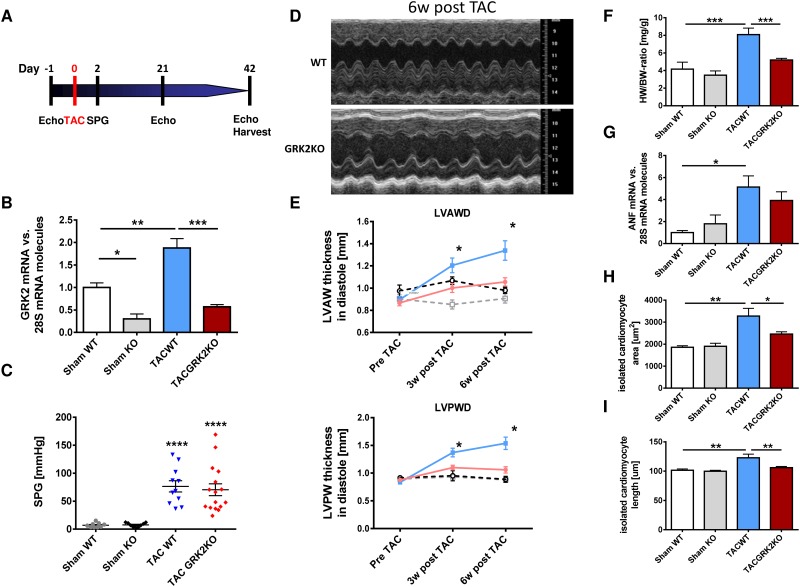
G-protein coupled receptor kinase 2 knockout (GRK2KO) attenuates cardiac hypertrophy in vivo.(A) Study design and in vivo model of pressure overload hypertrophy. Experimental protocol, echocardiography (Echo), transverse aortic constriction (TAC), Doppler measurement of systolic pressure gradient (SPG), organ harvest at study end (Harvest). (B) GRK2 mRNA expression normalized to 28s RNA 6 weeks after TAC operation, n = 3 for KO, n = 4–5 for WT groups, * P < 0.05, ** P < 0.01, *** P < 0.001. (C) Doppler measurement of aortic systolic pressure gradient (SPG) after TAC, n = 9 for sham, n = 11 for TAC WT and n = 16 for TAC GRK2 group. *** P < 0.0001 for TAC vs. Sham groups. (D) Representative M-Mode echocardiography recordings at study end, 6 weeks post TAC. (E) Echocardiographic assessment of ventricular remodeling. Left ventricular anterior/posterior wall thickness/diameter (LVAWD and LVPWD) determined before, 3 weeks and 6 weeks after TAC or sham operation in GRK2KO and wild-type (WT) animals. TAC GRK2 KO (red line, n = 18), TAC WT (blue line, n = 13), Sham GRK2KO (black dotted line, n = 6), Sham WT (grey dotted line, n = 8), * P < 0.05 TAC WT vs. TAC GRK2KO. (F) Heart-weight to body-weight ratio (HW/BW) measured at study end, 6 weeks after TAC, n = 4 for sham, n = 9 for TAC WT and n = 12 for TAC GRK2 KO group. (G) Atrial natriuretic factor (ANF) mRNA normalized to 28S RNA and Sham WT group showing attenuated ANF upregulation in GRK2 KO animals after TAC, n = 3–6. (H + I) Measurements of cell area and cell length from isolated adult ventricular cardiac myocytes (AVCM), n = 4 for sham groups, n = 9 for TAC WT and n = 12 for TAC GRK2 K, 20 cells per animal were measured; F-I * P < 0.05; ** P < 0.01; *** P < 0.001.